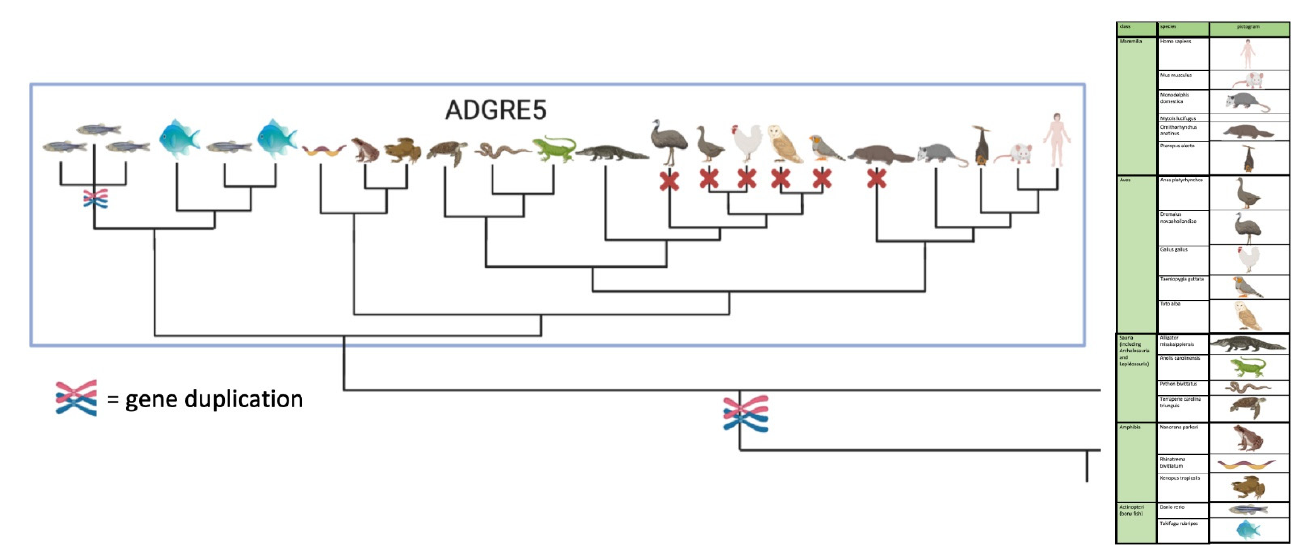
Figure 3. Scheme of the phylogenetic relation of vertebrate CD97/ADGRE5. CD97/ADGRE5 is present in fish, amphibian, reptile, marsupial, and eutherian genomes but not in birds and platypus. The full figure with all members of the ADGRE family is given in Figure S1E generated with BioRender.com.